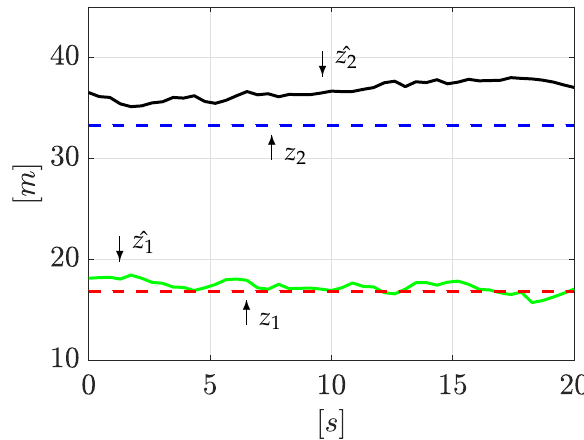
Figure 10. Estimation of leak positions (2nd experiment). Continuing with the algorithm, the leak magnitudes are computed with Equations (31) and (32). These results are shown in Figure 11.